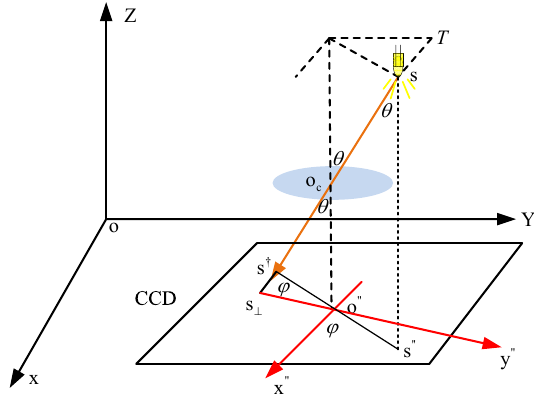
Figure 3. Schematic diagram of the angle measurements acquirement.